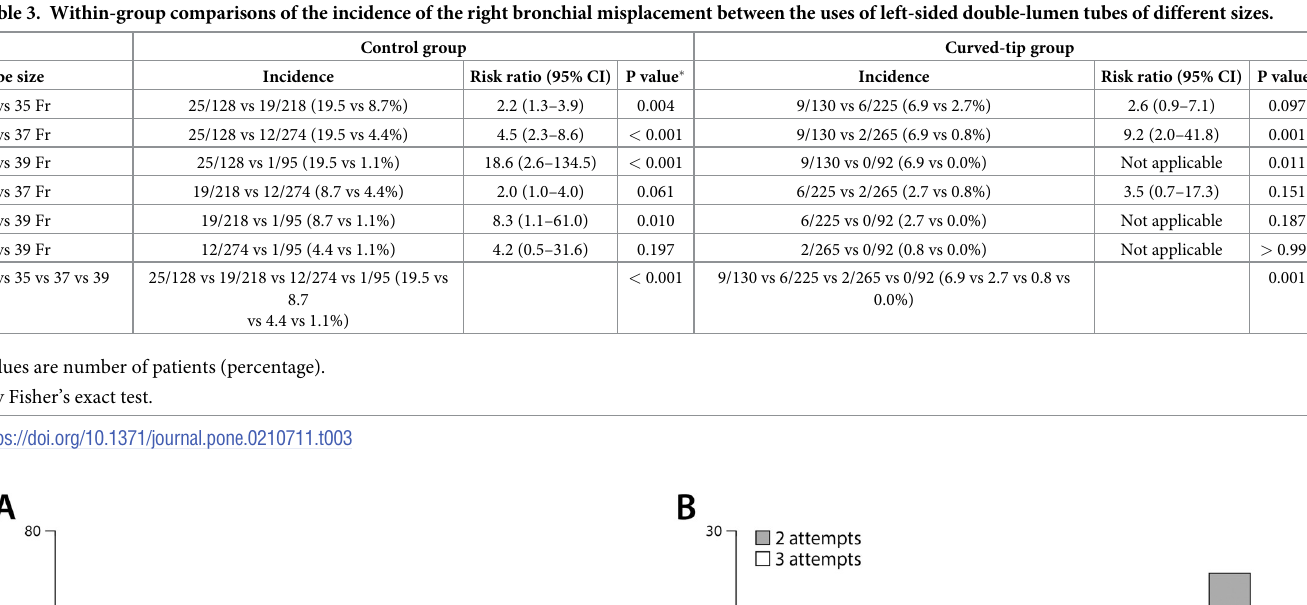
Values are number of patients (percentage). �